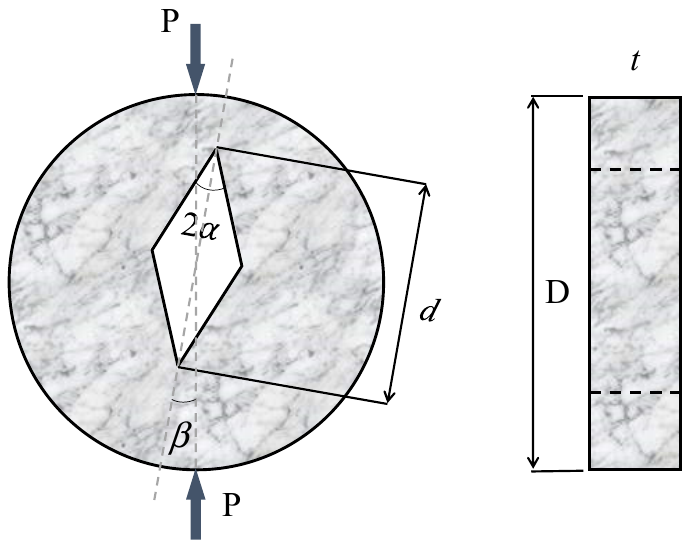
Figure 1. Schematic of SVNBD samples under mixed mode I/II loading.